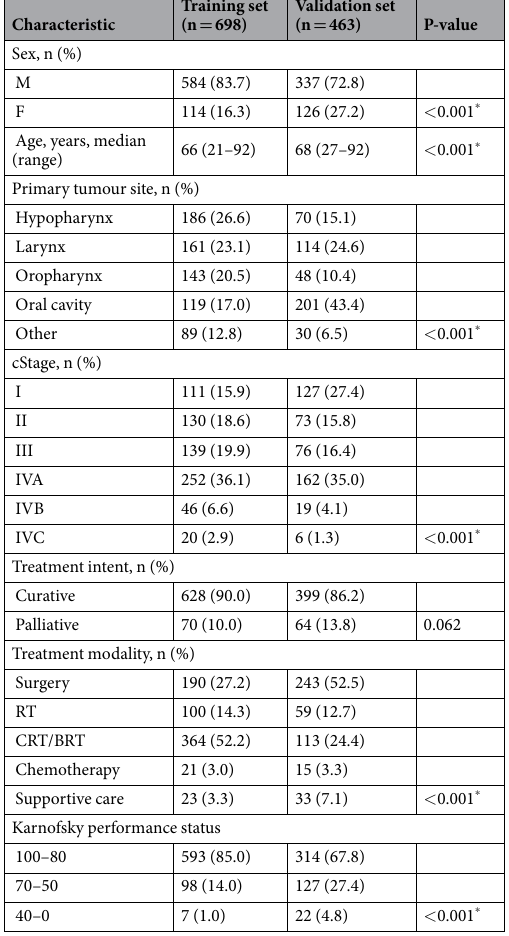
Table 1. Characteristics of patients in the training (n = 698) and validation (n = 463) sets. * P < 0.05. BRT, bioradiotherapy; CRT, chemoradiotherapy; cStage, clinical stage; F, female; M, male; RT,